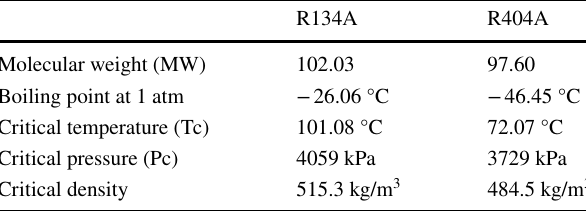
Fig. 2 The molecular structures of R134A, R125, and R143A gases